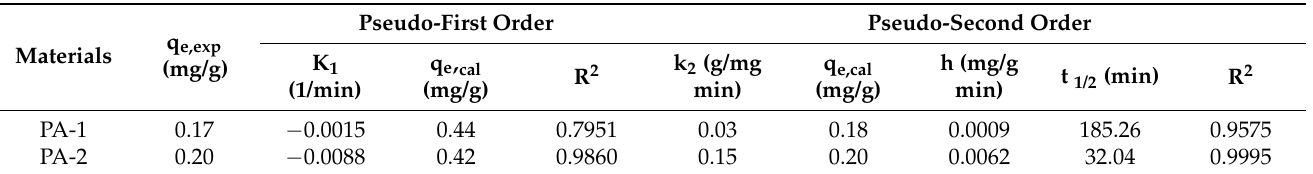
Table 4. Kinetic parameter of fluoride by pseudo-first order and pseudo-second order